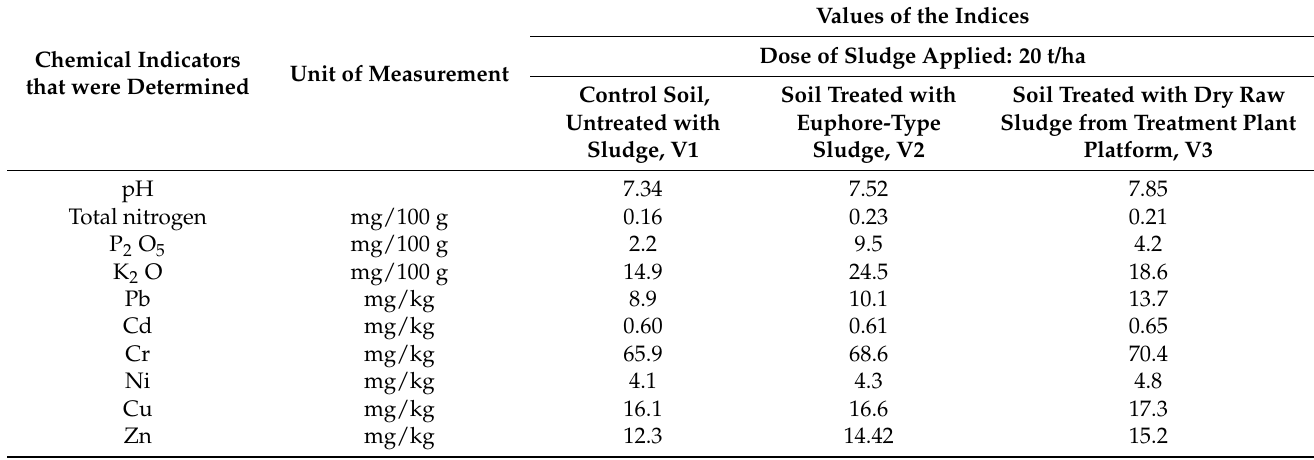
Table 14. Average values of agrochemical soil characteristics in the